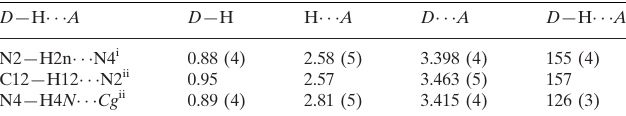
Hydrogen-bond geometry (A˚ , (cid:2) ). Cg is the centroid of the C6–C11